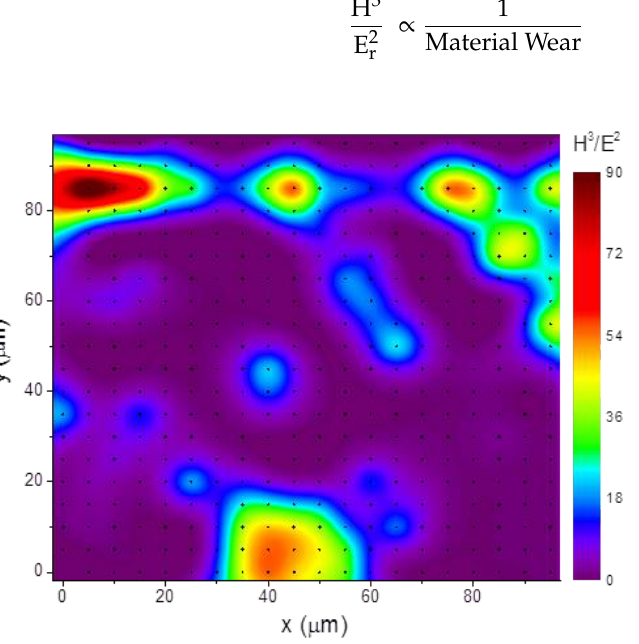
Figure 13. Map made using instrumented nanoindentation with a matrix of 20 × 20 indentations, made with respect to H 3 3 made with respect to H . E 2 r E r2